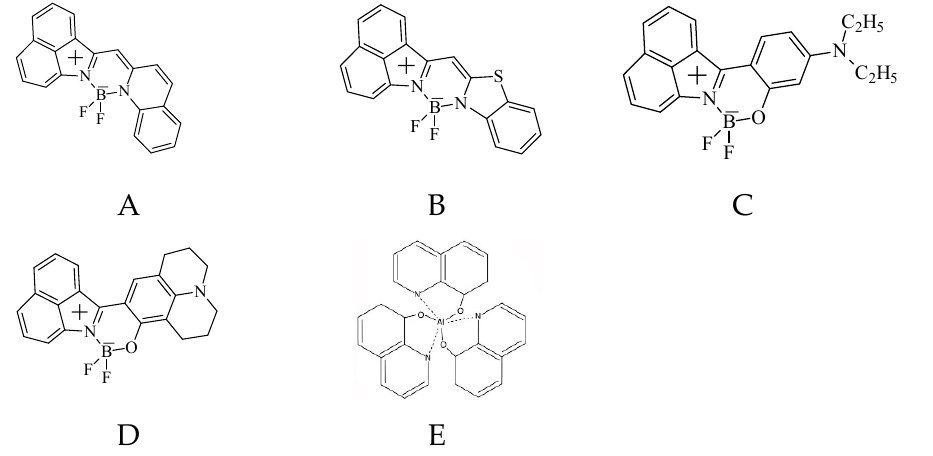
Figure 1. The chemical structures of guest dyes (I ( A ), II ( B ), III ( C ), IV ( D )), and Alq 3 ( E ) matrix. Thin films were grown by thermal vacuum deposition method on glass and quartz substrates under the pressure of the order 1 × 10 − 5 Pa. Composite films were fabricated through co-evaporation of dye (dopant) together with Alq 3 (matrix). Each composite